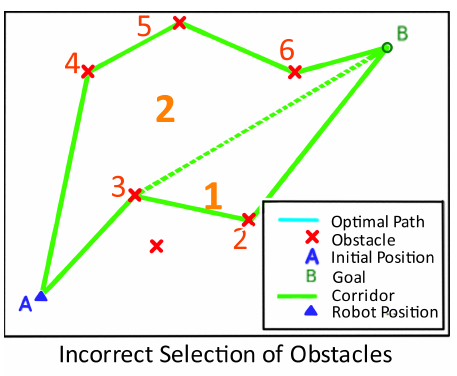
Figure 6. How the corridors merge after removal of extra